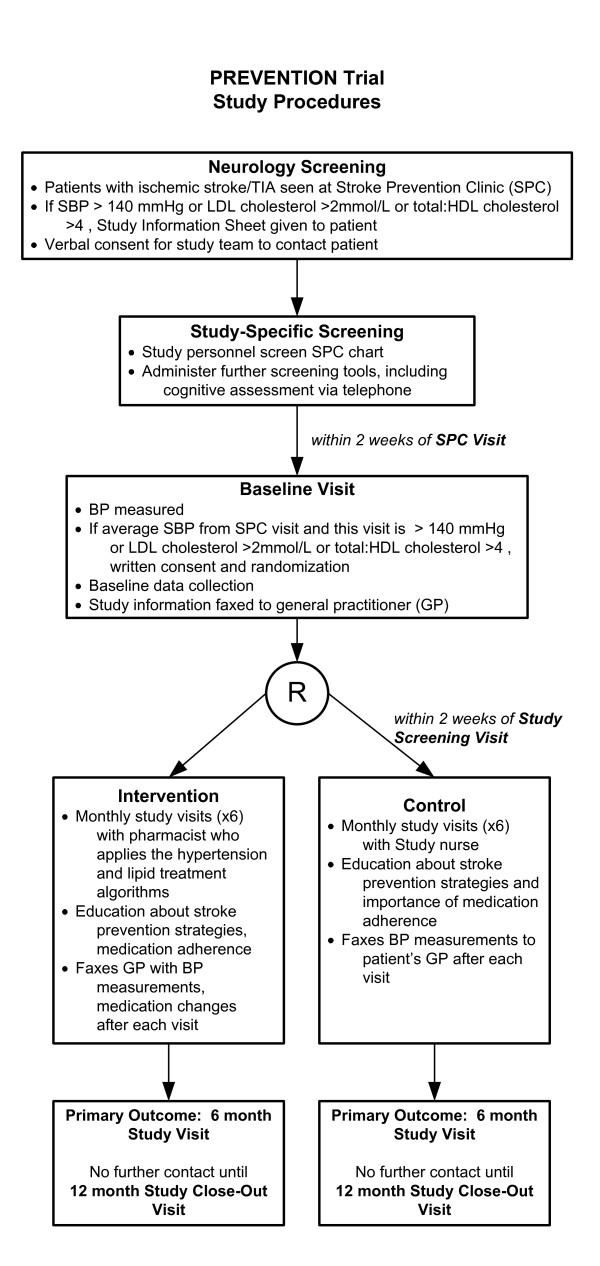
Prevention Trial Study Procedures. TIA = transient ischemic attack, SPC = stroke prevention clinic, SBP = systolic blood pressure, GP = general practitioner.